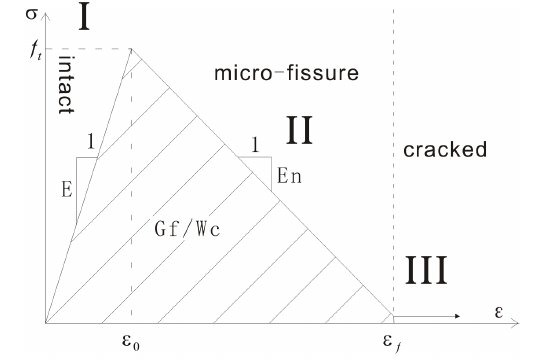
Figure 1. Constitutive relation in CBM.